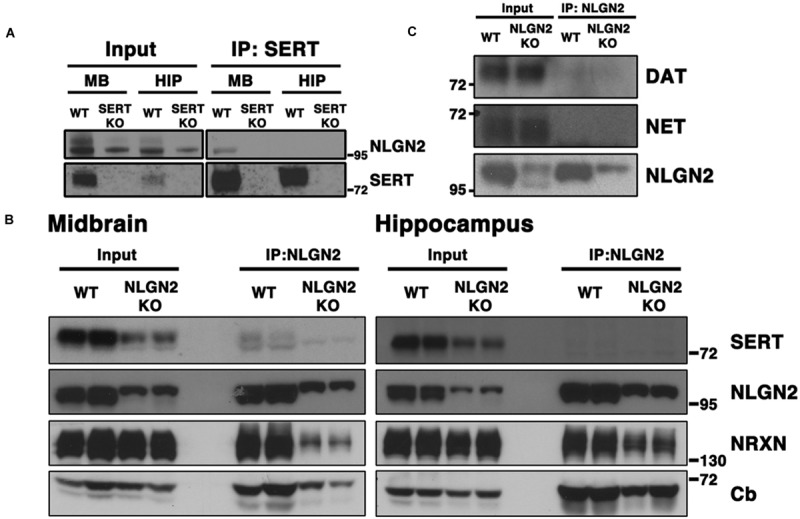
NLGN2 forms midbrain-specific protein complexes with SERT. (A) Co-immunoprecipitation assay with SERT antibody, using SERT null mice as negative controls; (B) Co-immunoprecipitation assay with NLGN2 antibody, using NLGN2 null mice as negative controls, NRXN: neurexin, Cb: collybistin; (C) NLGN2 does not form protein complexes with dopamine transporter (DAT) or norepinephrine transporter (NET). Input lanes represent 1% of total protein lysates, co-IP lanes represent 40% of total eluants. Each blot is a representative of three or more independent experiments.